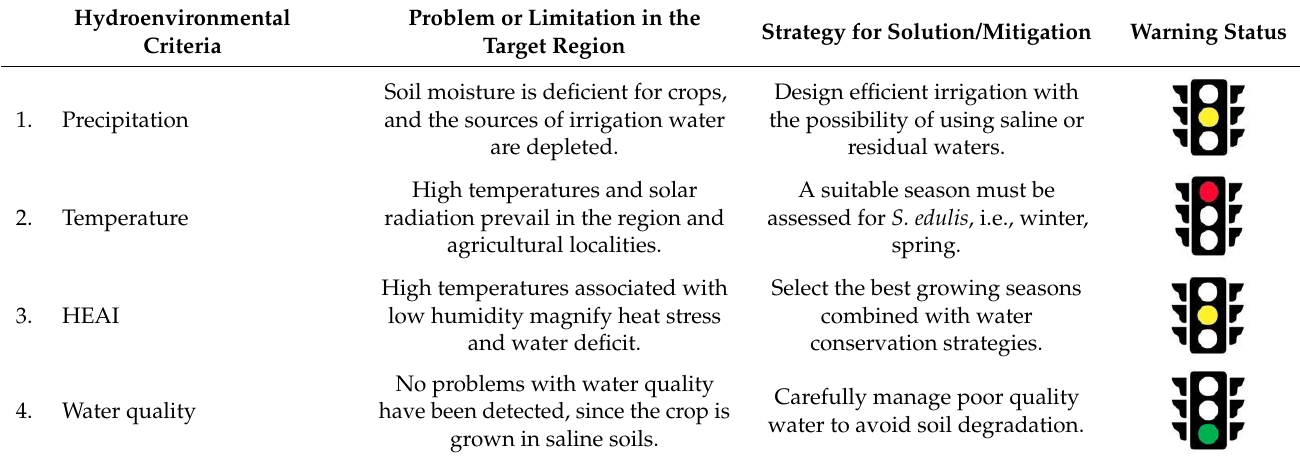
Table 3. Hydro-environmental criteria and possible problems or limitations to be addressed as a consequence of introducing Suaeda edulis (‘Romerito’) from temperate rainy zones to a semiarid region of Northwest M é xico.